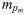
95%-probability intervals, represented by the starting and ending points (mp, mp+0.95) for the truncation parameter Mc of a TPL distribution with N = 7, 585 earthquakes (in terms of the corresponding truncation magnitude mc), as a function of the hypothetical true values of mc.The value of the exponent is 1 + β = 1.67. Two kinds of intervals are shown: symmetric (r = 1/2 in Eq (9)) and of minimum width (the r that gives minimum width is selected), labeled with mpm. The empirical value of the maximum observed magnitude in the global CMT catalog for the 7,585 considered earthquakes is shown as a horizontal line. When the line is outside the interval, the parameter value mc should be rejected.